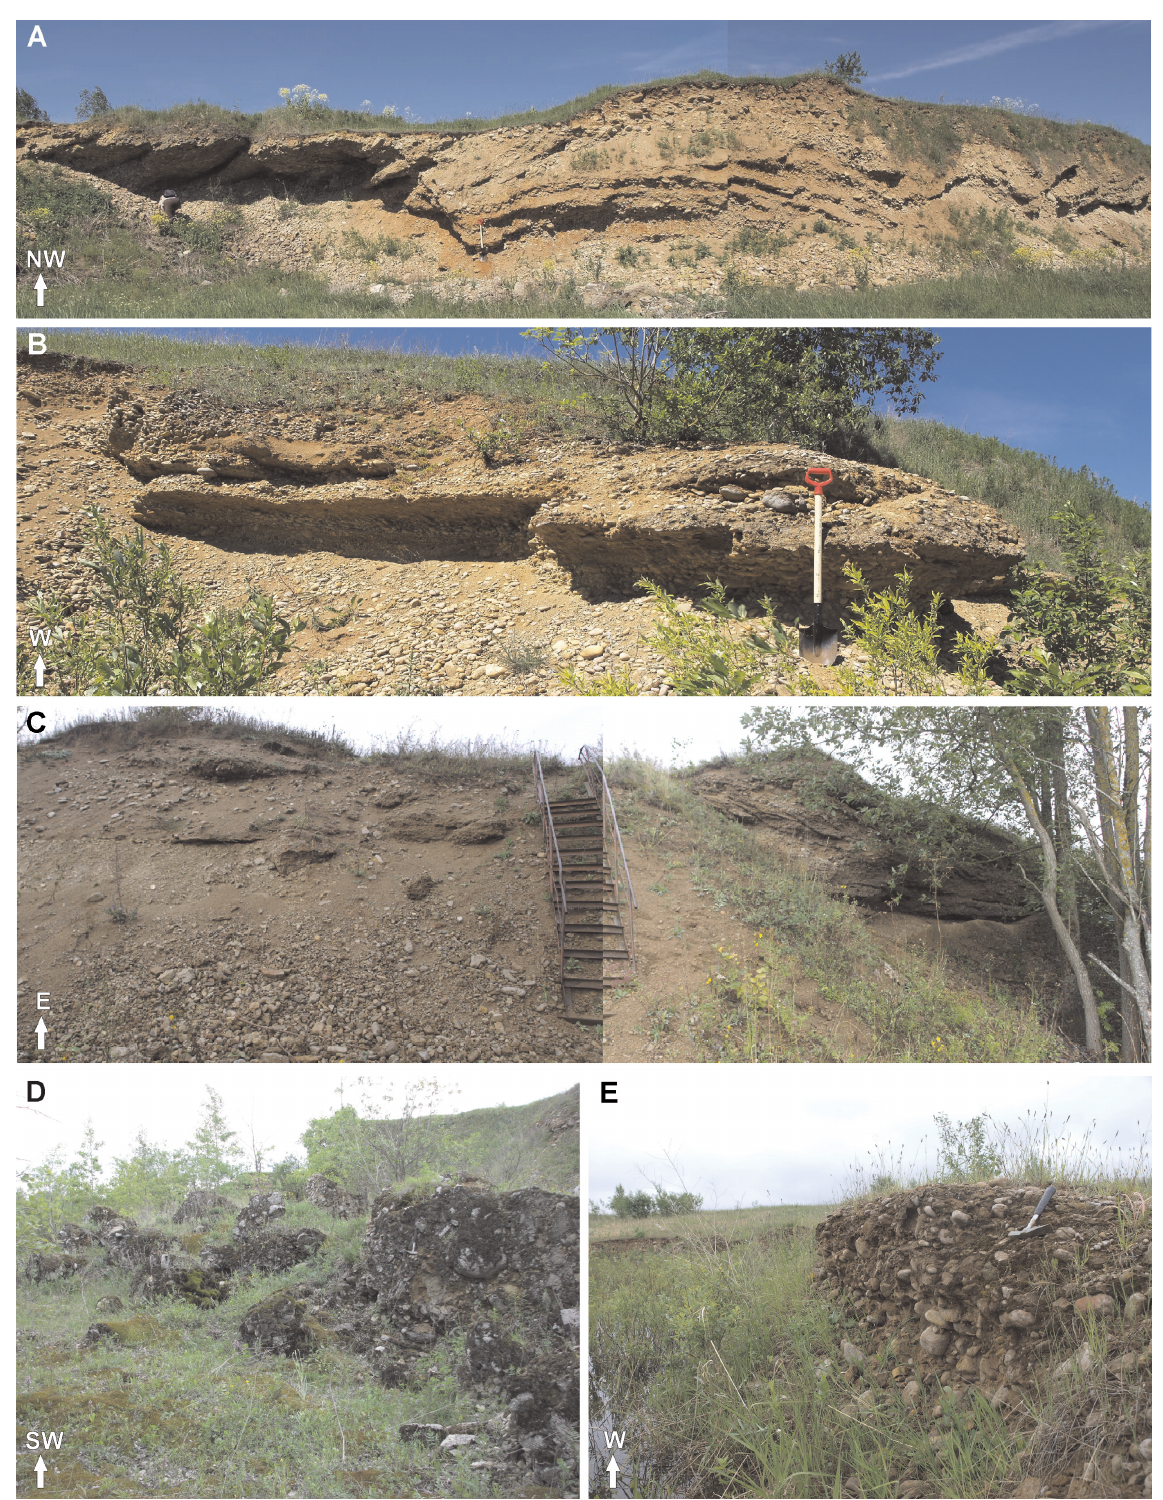
Fig. 3. Studied exposures. See Fig. 1 for locations and Fig. 2 for geological settings. A , a lateral continuous up to 3 m thick cemented gravel layer on the top of the ridge, Pehka site; B , a cemented up to 2 m thick layer in the upper part of the gravel unit, Moldova site; C , a cemented 2 m thick gravel layer on the top of outwash deposits, southern slope of the Tornimägi hill; D , cemented rafts from outwash deposits left at the bottom of the quarry, Kunda site; E , an up to 1 m thick cemented layer on the bottom of the quarry, Laagna site. Hammer length 30